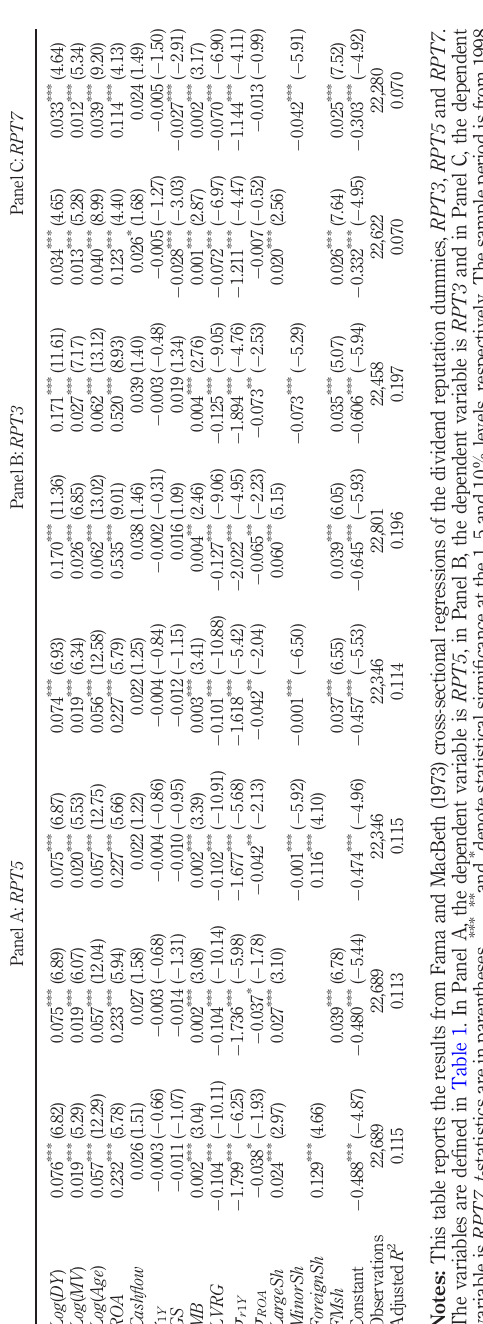
Table 7. Determinants